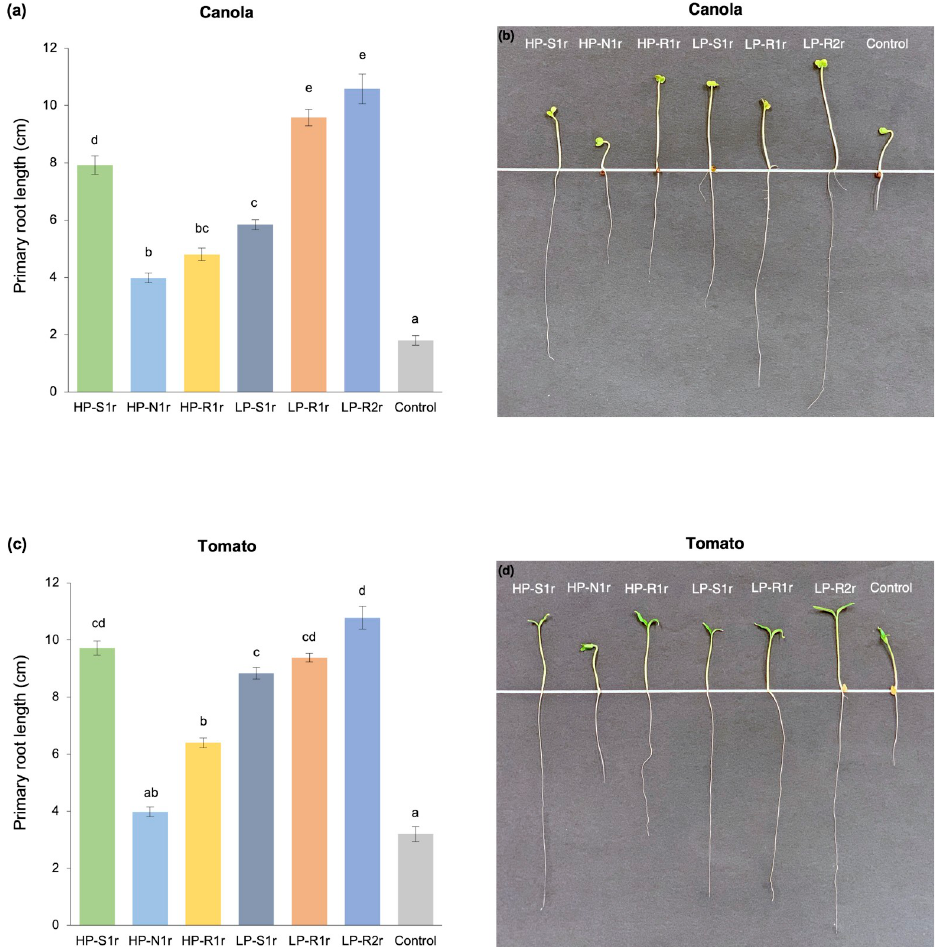
Fig 5. Primary root length of (a), (b) canola and (c), (d) tomato seedlings subjected to six bacteria-inoculated ( Caballeronia sordidicola HP-S1r, Pseudomonas frederiksbergensis HP-N1r, Phyllobacterium myrsinacearum HP-R1r, Pseudomonas mandelii LP-S1r, Paraburkholderia phytofirmans LP-R1r and Caballeronia udeis LP-R2r) and one non- inoculated control treatments. Seedlings were evaluated five days after germination in the gnotobiotic root elongation assay to evaluate in situ ACC deaminase activity. Error bars represent standard errors of the mean (n = 7 seedlings per treatment) and bars with different letters are significantly different (P < 0.05).